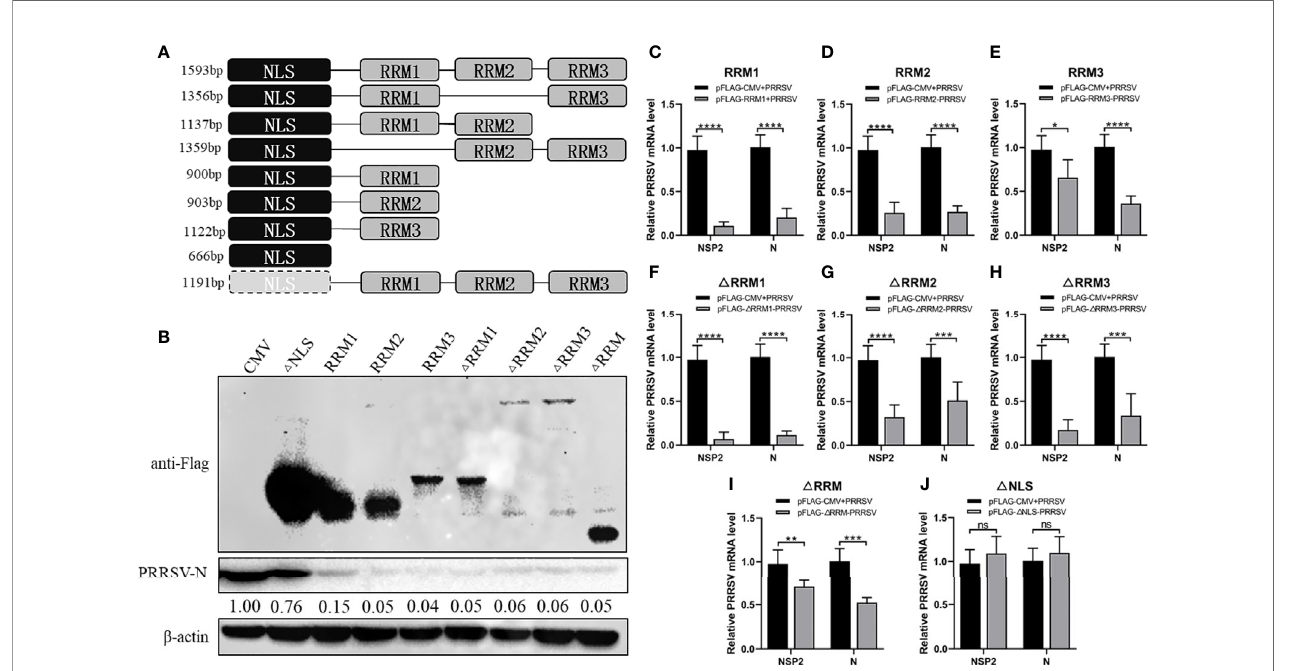
FIGURE 3 | The RRM domain of RBM39 is important to promote the proliferation of PRRSV. (A) The constructed 8 truncated forms of RBM39 via the reverse ampli fi cation method, namely Flag-RRM1, RRM2, RRM3, D RRM1, D RRM2, D RRM3, D RRM, D NLS. (B – J) 3D4/21 cells were transfected with 8 truncations and infected with PRRSV after 12 h. After 24 hours, the proliferation of PRRSV was detected by Western Blot analysis (B) and qRT-PCR (C – J) . Data are representative of results from three independent experiments. The statistically signi fi cant at P-value was demonstrated in Statistical Analysis . ns, no signi fi cant